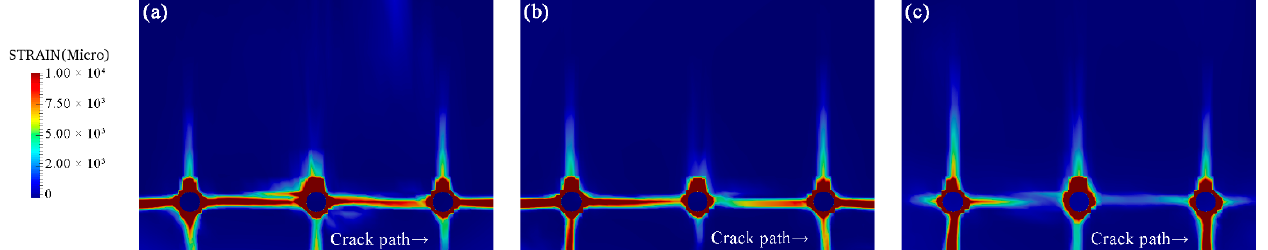
Figure 12. The principle strain of the beam section under different loading conditions (serviceability limit state): ( a ) S-L00, ( b ) S-L30, and ( c ) S-L60.